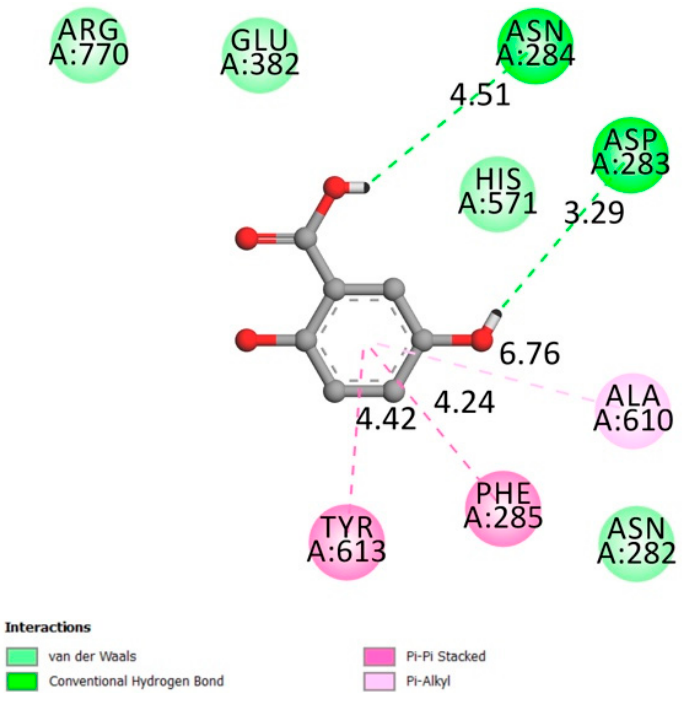
Figure 6. Two-dimensional scheme of the GA interactions with glycogen phosphorylase receptor. Glycogen phosphorylase is known to be one of the causes of hyperglycemia since it